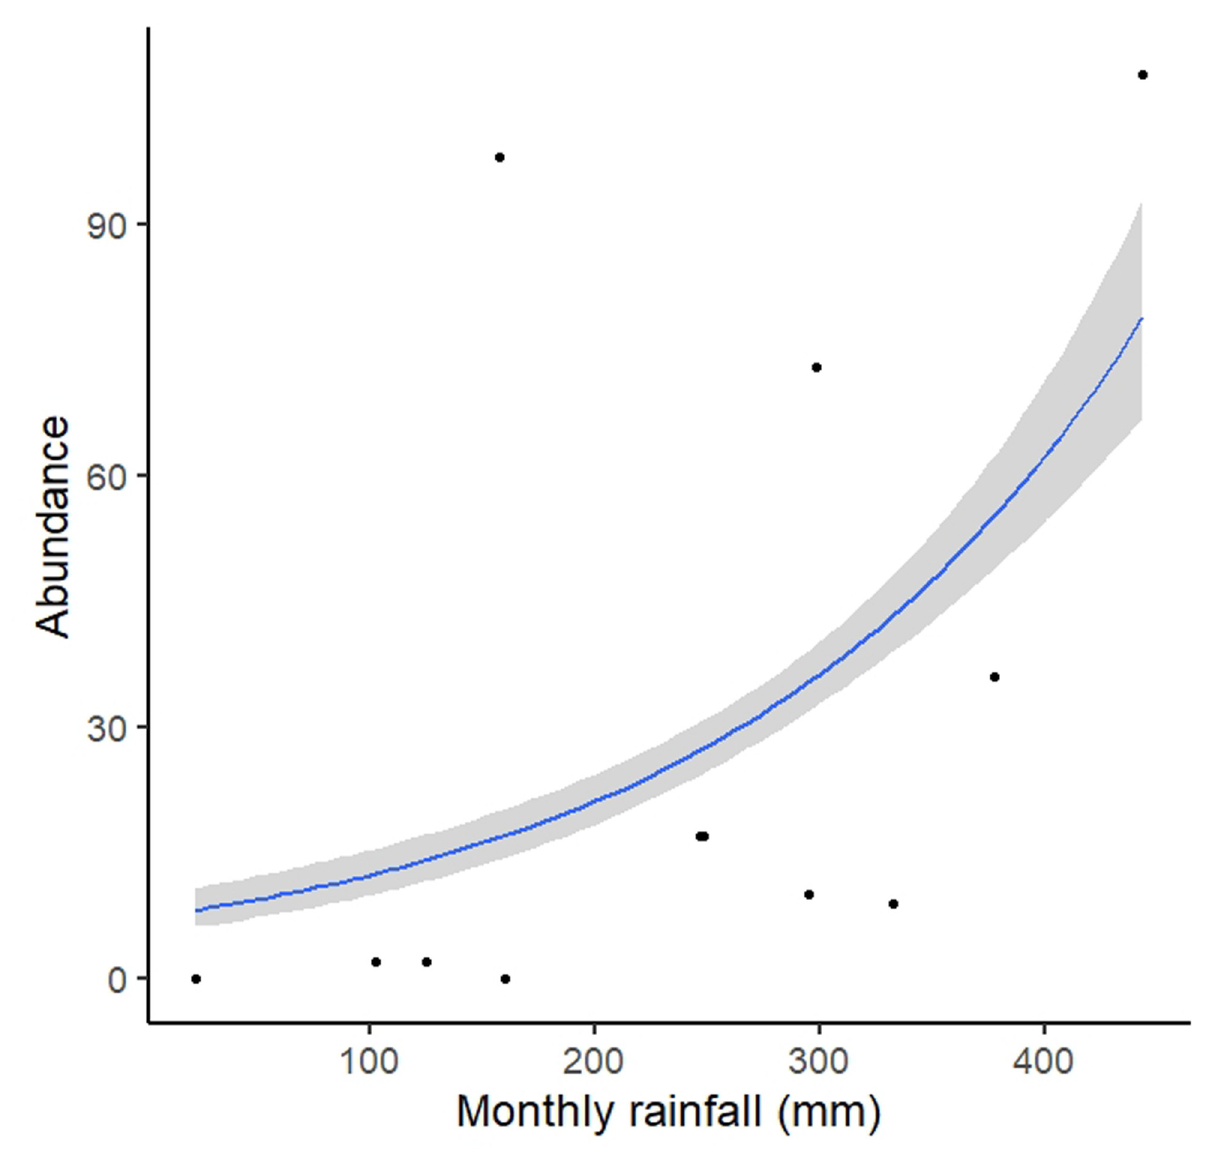
Fig 9. Relationship between observed Brachycephalus rotenbergae sp. nov. specimens and monthly precipitation (in mm). Notice that the number of specimens found per field survey reaches zero during months with precipitation under 200